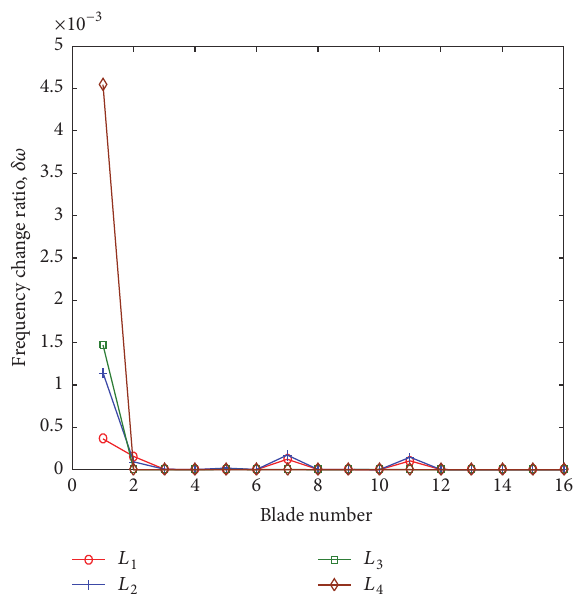
Figure 11: Frequencies change of MRBs under different 𝑎 .